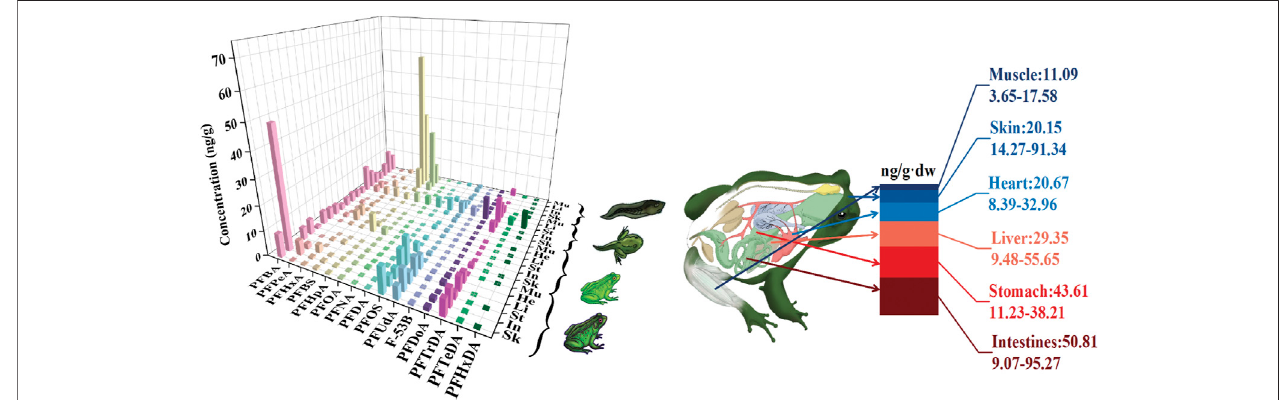
FIGURE 3 | PFASs in bullfrog tissues during different growth periods from bullfrog bases.